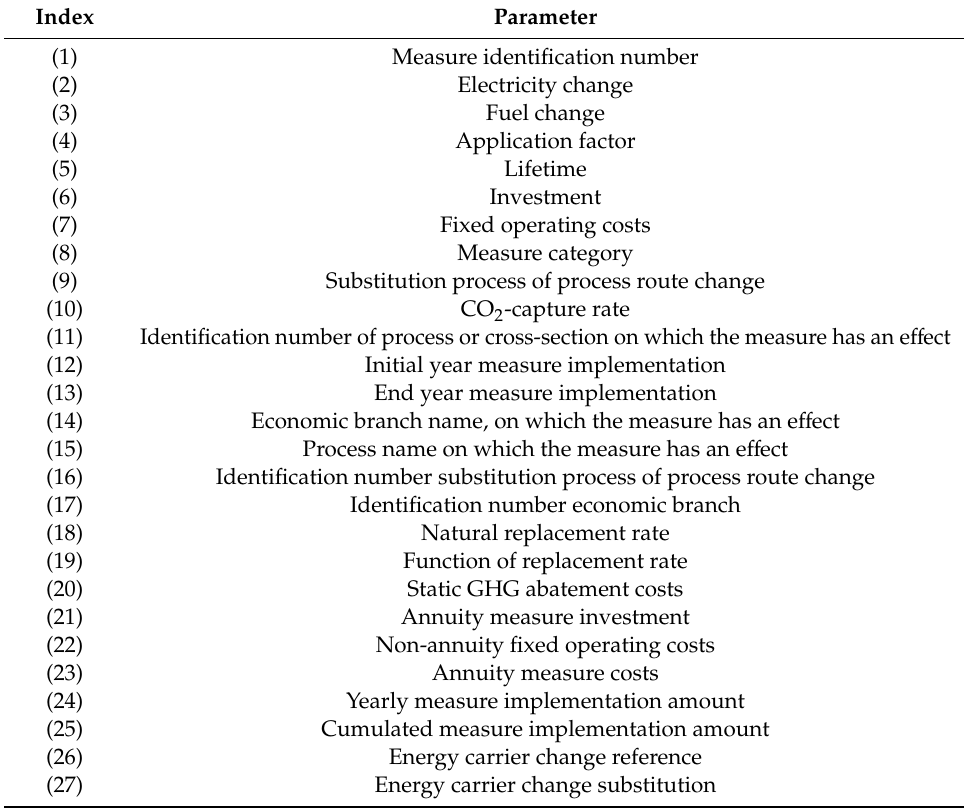
Table A1. Parameters of the yearly process and economic branch comprehensive measure